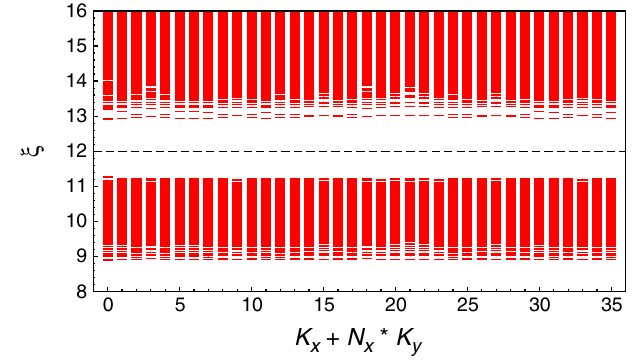
FIG. 13. Particle entanglement spectrum for N ¼ 12 , N x ¼ 6 , and N 4 . The (cid:9) ’s are the entanglement energies. N y ¼ A ¼ The number of states below the dashed line is 741 in momentum sectors where N x mod 2 ¼ N y mod 2 ¼ 0 and 728 elsewhere. The total number below this line (26 325) exactly matches the one predicted by the counting rule.